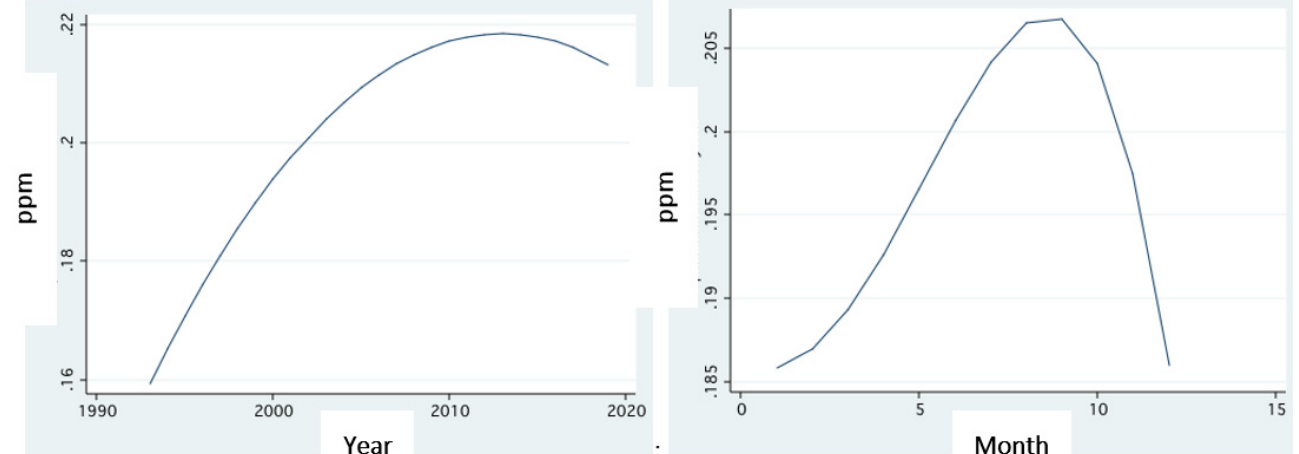
Figure 14. Temporal changes (annual— left ; monthly— right ) of total phosphorus concentrations (ppm), averaged for the entire Hula Valley runoff during 1993–2020 (fractional polynomial regression).